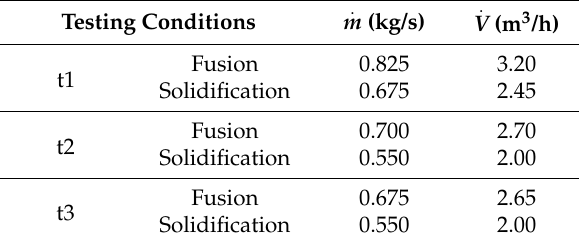
Table 3. Mass and volume flow rate values of the heat transfer fluid for the adopted testing